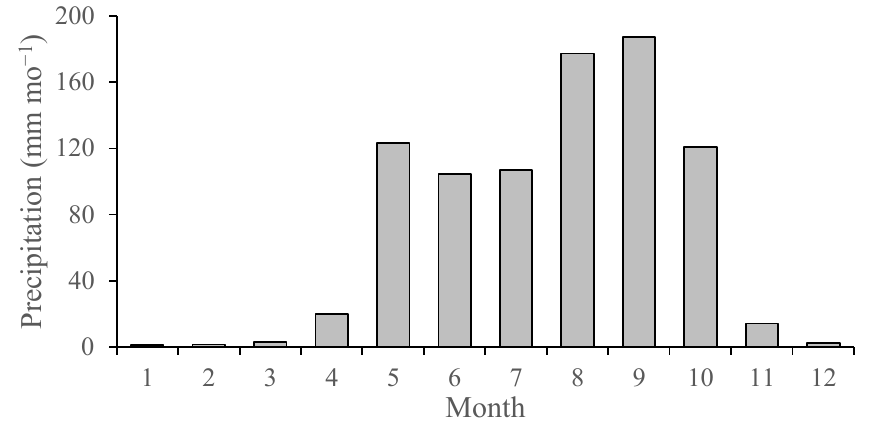
Figure 2. Annual average precipitation.